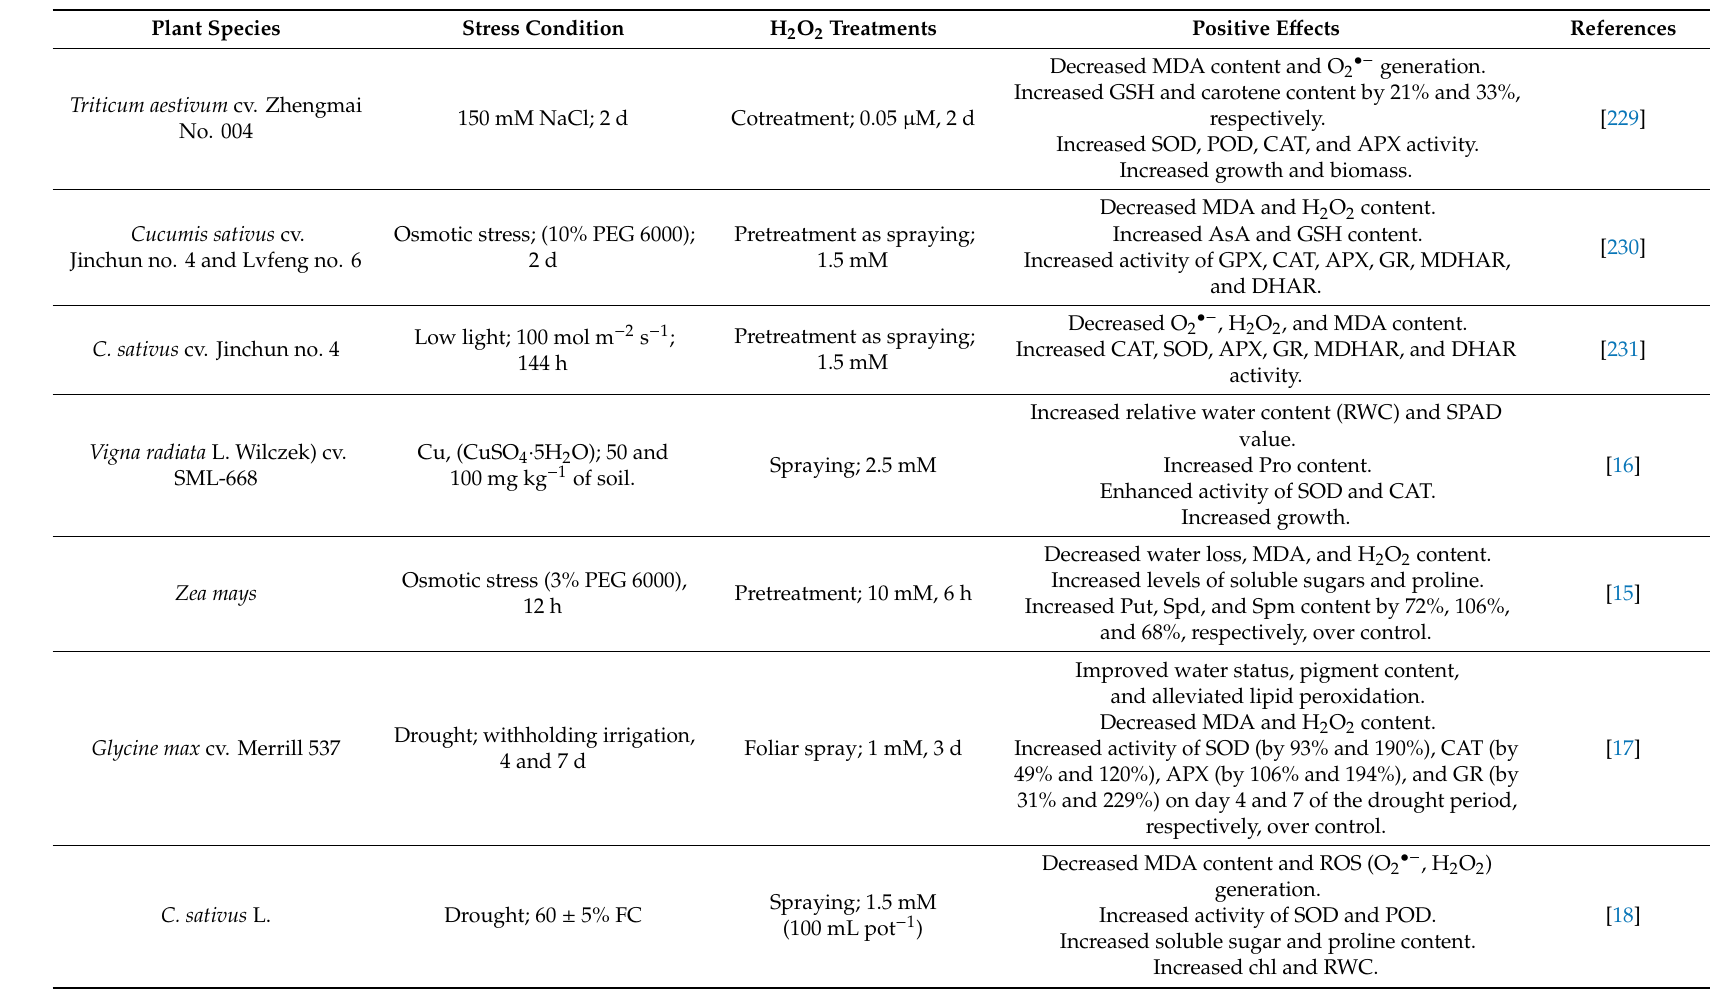
Table 4. E ff ect of exogenous H 2 O 2 in plants under di ff erent abiotic stress